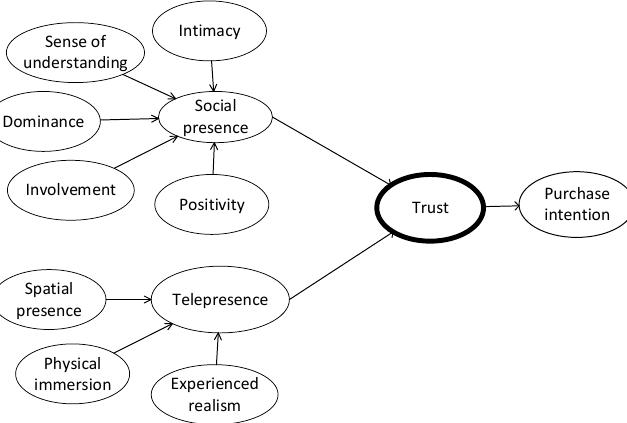
Figure 5. Conceptual framework of consumer trust of the VR shopping site.